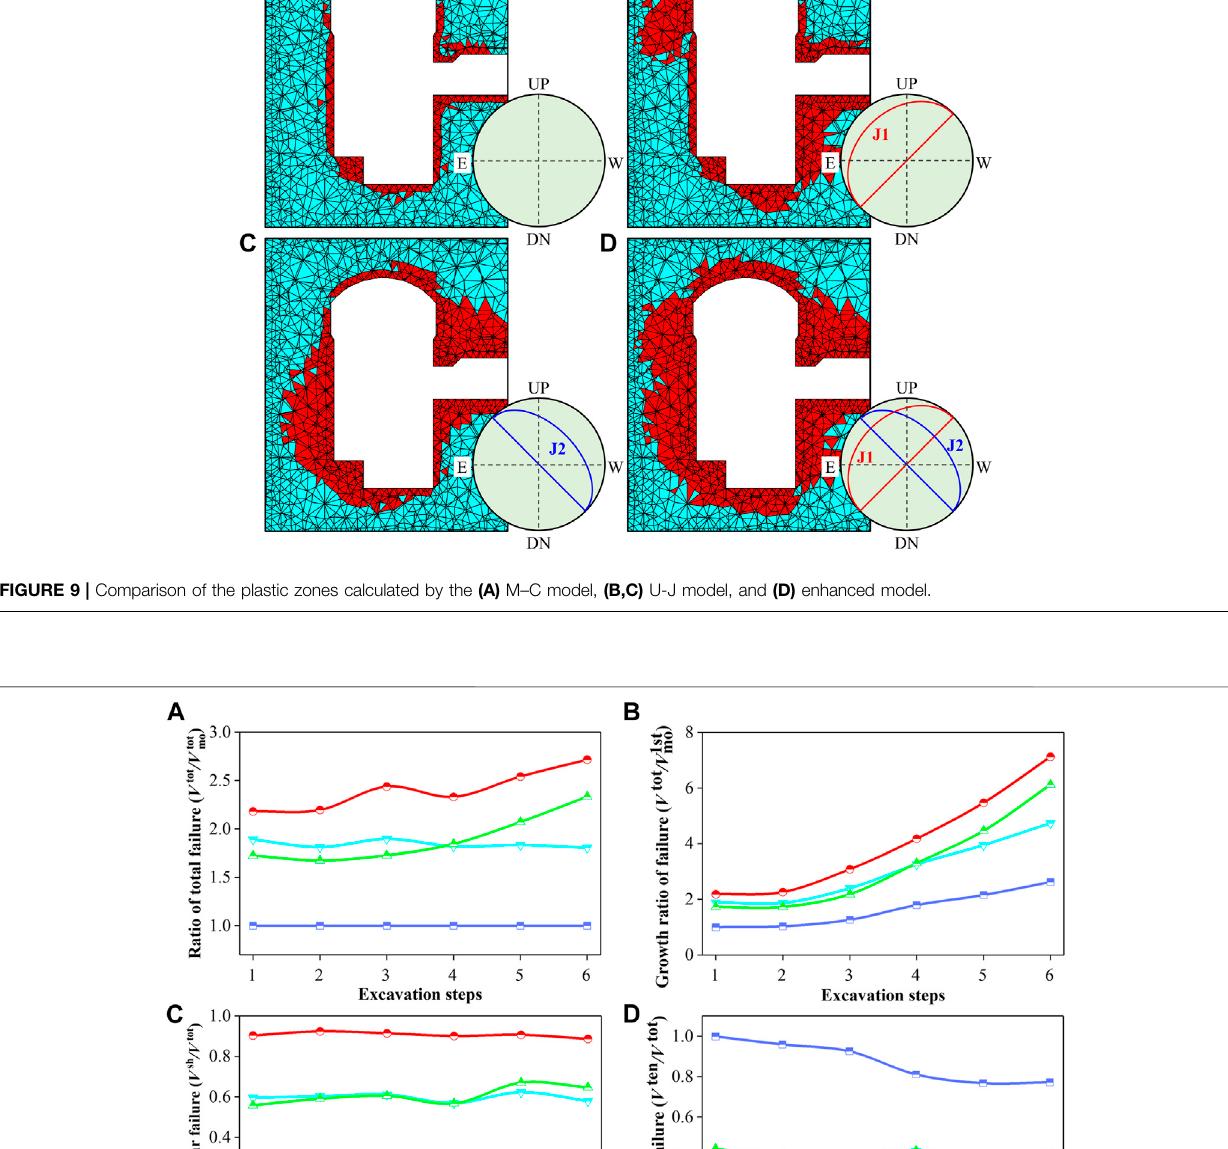
Frontiers in Earth Science |